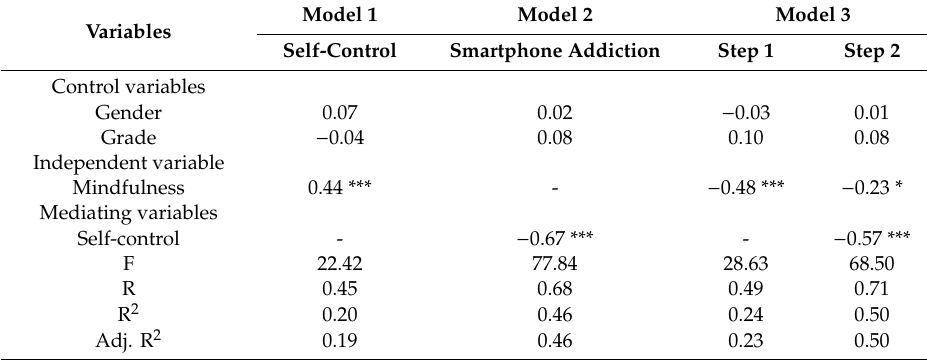
Table 2. The mediating e ff ect of self-control on the path from mindfulness to smartphone addiction before going to sleep.